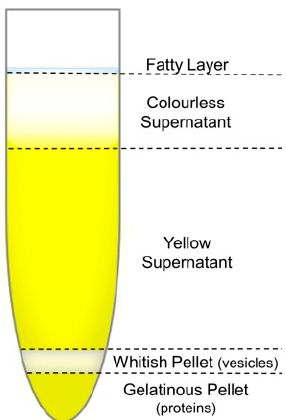
Figure 6. The fractions of the blood plasma sample after 8 h of ultracentrifugation at 100,000× g .